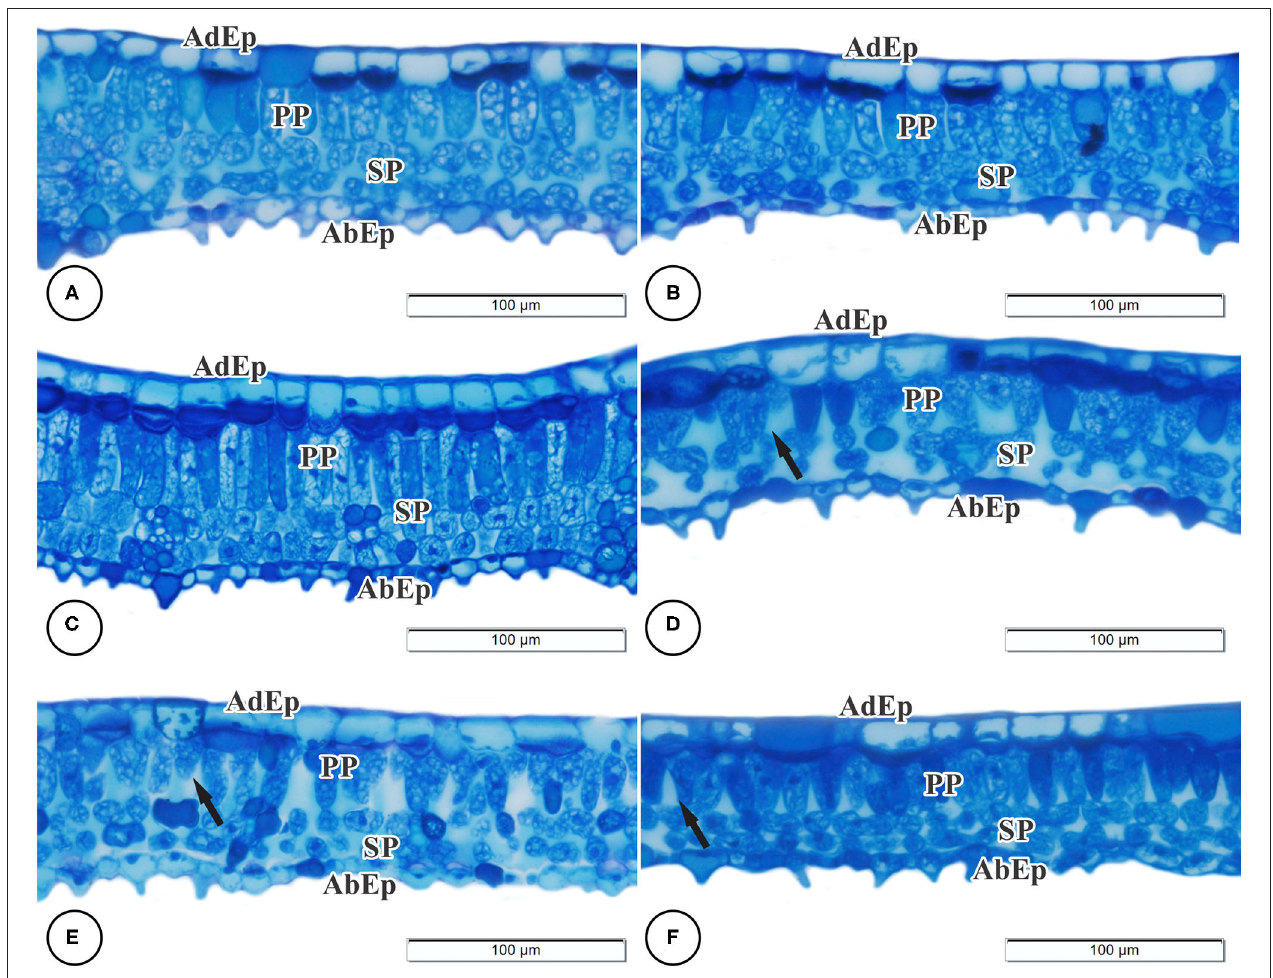
FIGURE 2 | Light microscopy of cross-sections of the leaves of Brosimum gaudichaudii . Treatments: white (A,B) , blue (C) , red (D) , B/R 1:1 (E) , and B/R 3:1 (F) . AdEp, adaxial epidermis. AbEp, abaxial epidermis. PP, palisade parenchyma. SP, spongy parenchyma. Black arrows indicate changes in cell structure. Scale bar = 100 µ